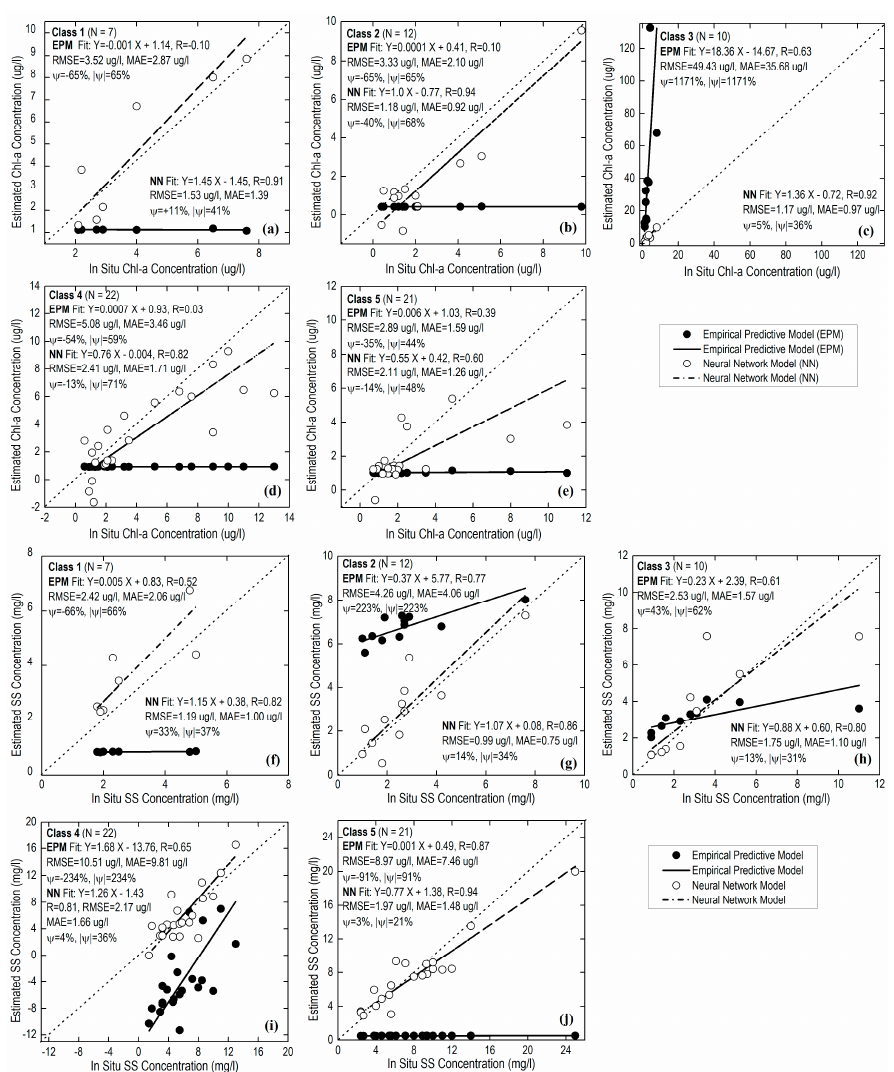
Figure 4. Validation results for the class-specific empirical predictive (EPM) and neural network (NN) models for Chl-a ( a – e ) and SS concentrations ( f – j ).